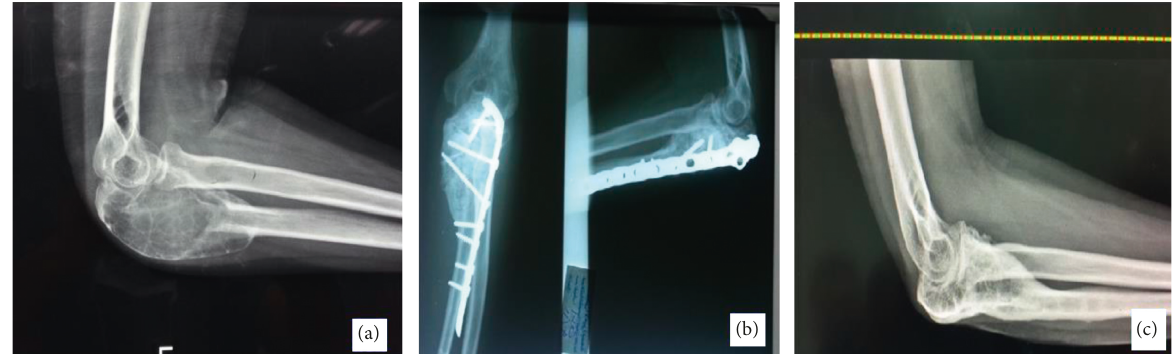
Figure 5: (a) Lateral elbow X-ray showing expansile cystic lesion involving the whole olecranon. (b) AP and lateral elbow X-rays after surgery with olecranon anatomical locking plate. (c) Lateral X-ray 4 years after removal of metal showing complete healing of the lesion.